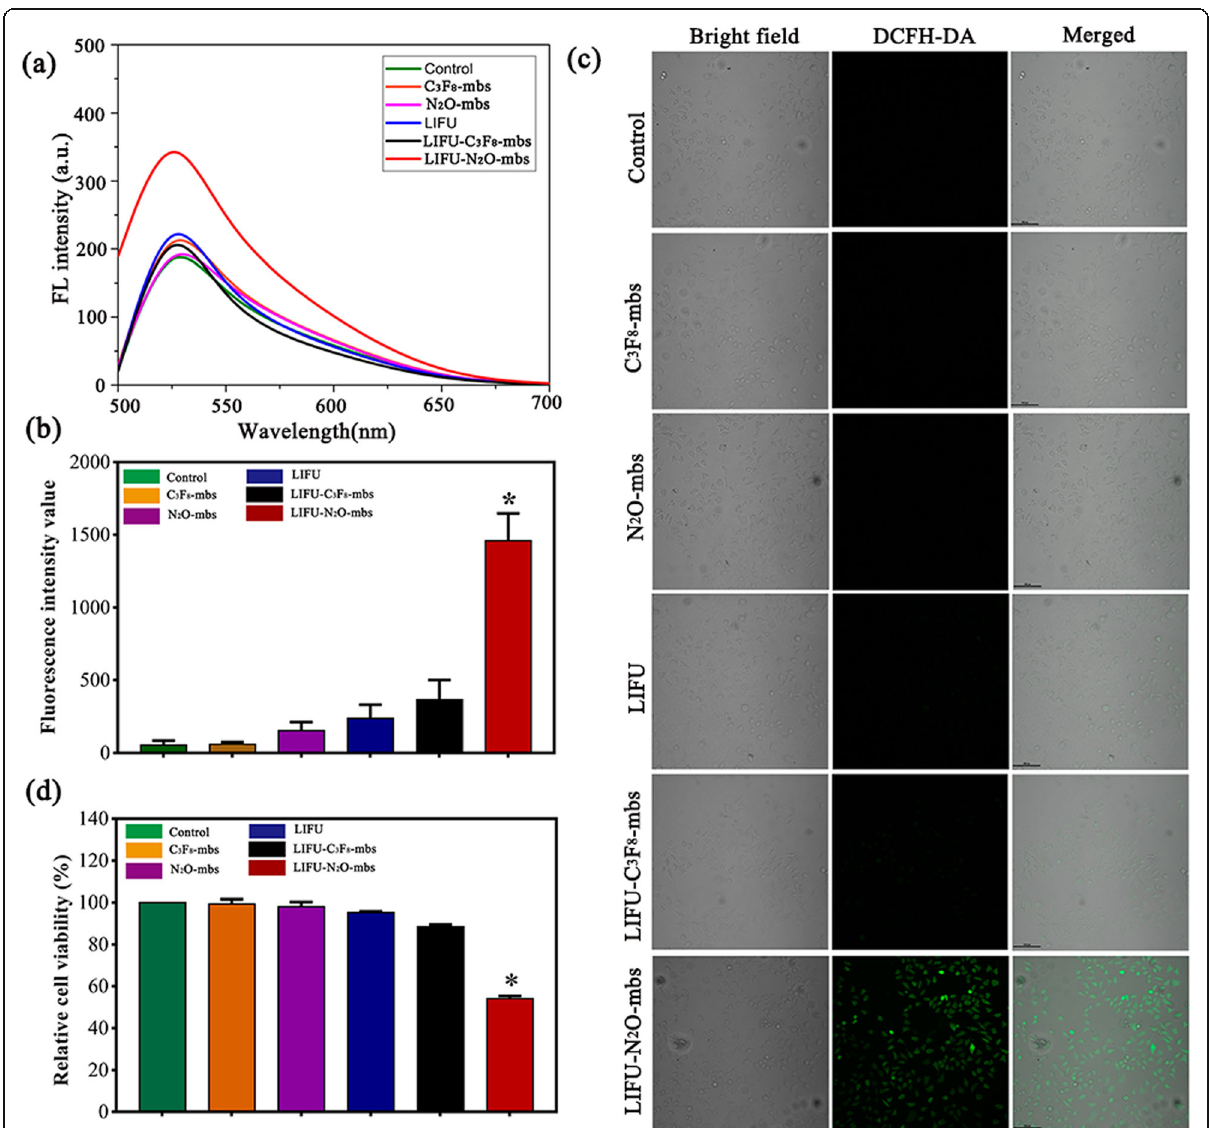
Fig. 3 a Fluorescence spectrum of SOSG with N 2 O-mbs irradiated by LIFU; b cell viability was determined by CCK8 assay; c confocal images of intracellular ROS generation (green fluorescence indicates positive staining for ROS stained with DCFH-DA); d the average fluorescence intensity value (DCFH-DA) of each group calculated by Image J. (The data were shown as mean ± SD, n = 5 per group, * p < 0.05, compared